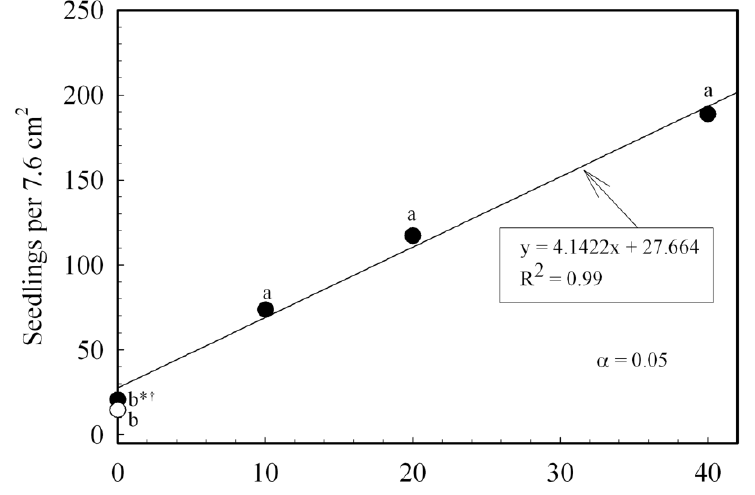
Figure 3. Effect of incorporating composted poultry litter into top 12.7 cm of subsoil on Kentucky bluegrass seedling density; * Means with same letters are statistically insignificant based on Fisher’s Protected LSD test ( P ≤ 0.05); † values for standard error were small ranging between 0.21 (min.) to 0.82 (max.) and hence are not shown in